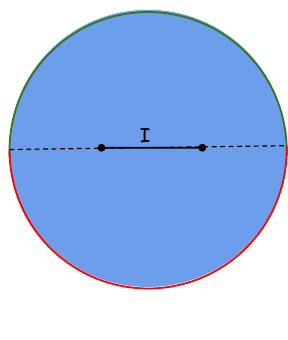
Figure 8. The island region in the original